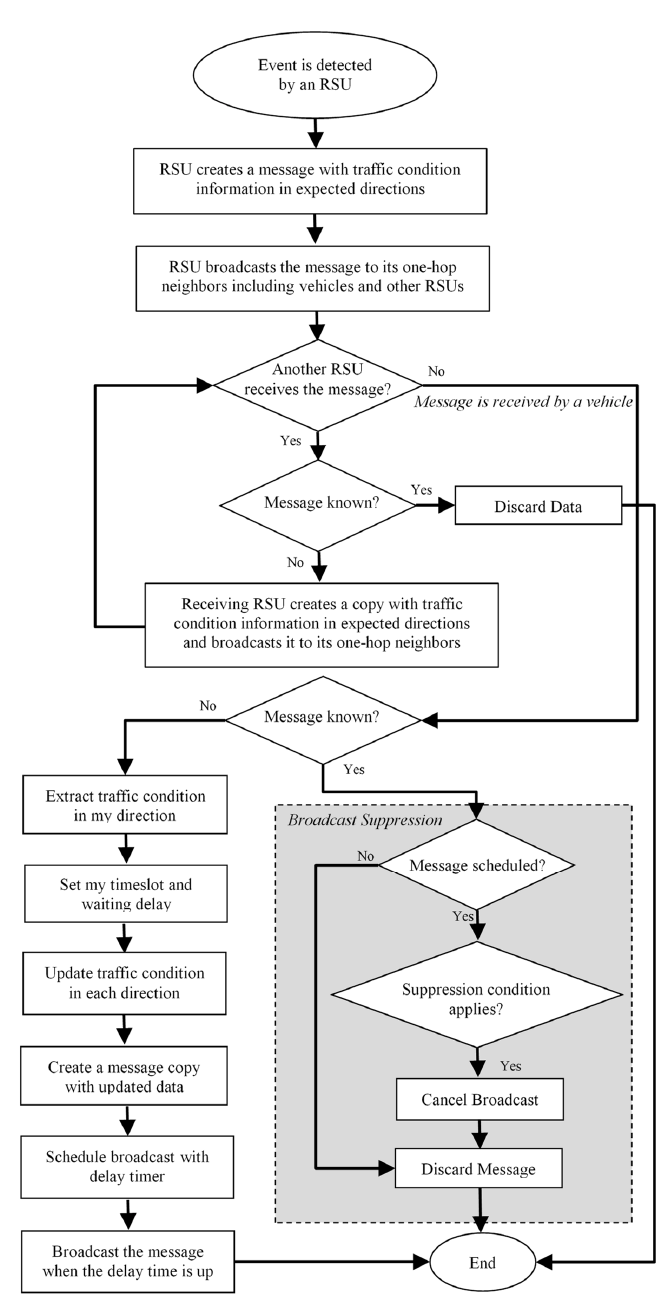
Figure 3. Our Proposed Edge ‐ based Data Dissemination Protocol.